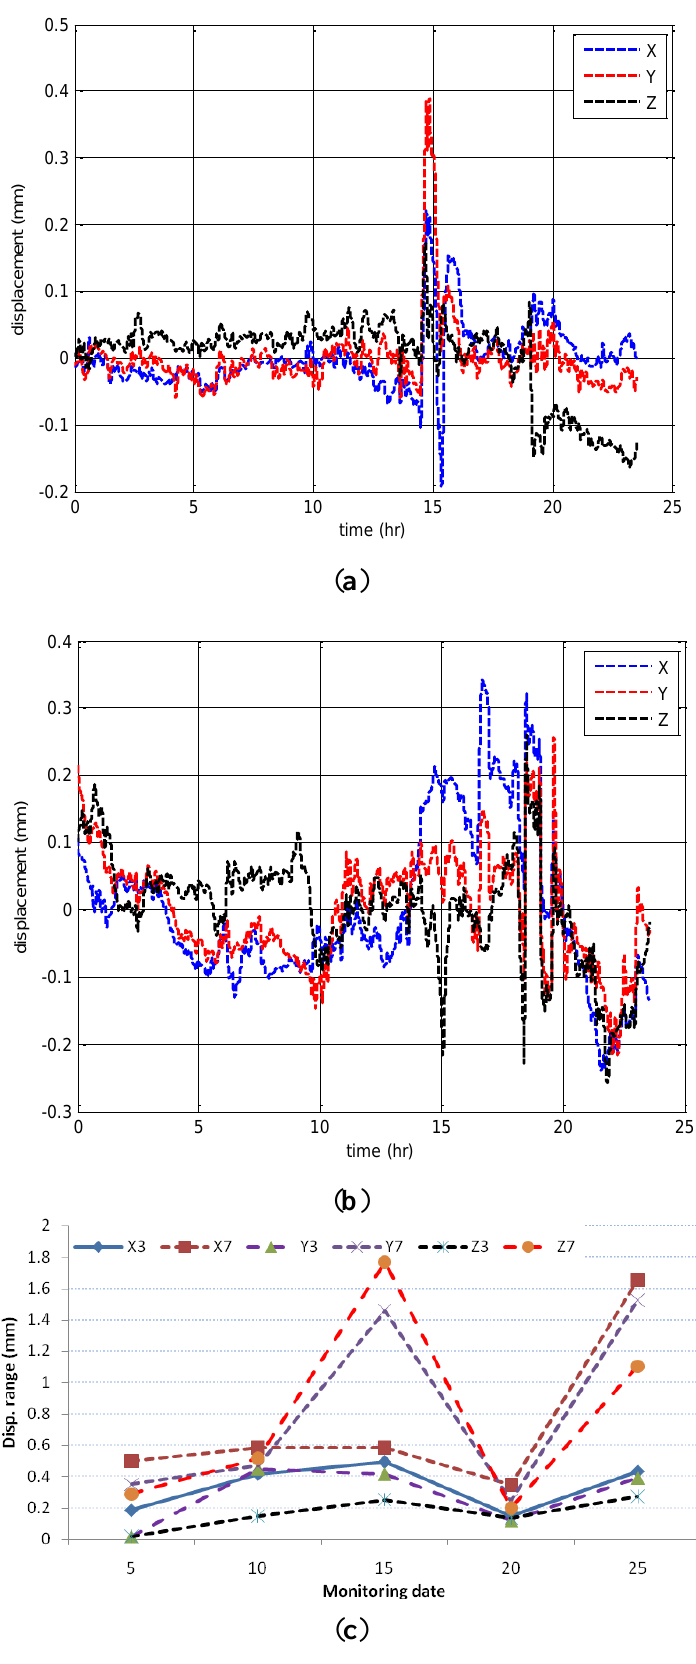
Figure 10. Displacement time series of bridge deck on 10 Sept. for ( a ) point 3; ( b ) point 7 and ( c ) Displacement range of GPS